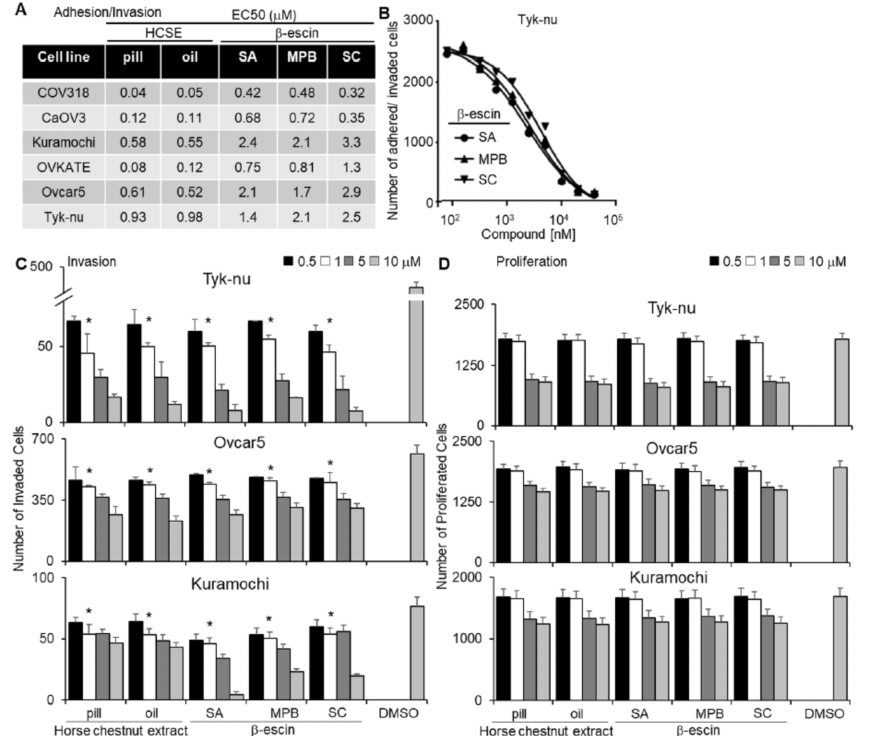
Figure 1. Testing different sources of β -escin in functional assays using a 3D organotypic model. Two horse chestnut extracts (HCSE) and three different sources of β -escin were tested at 12 doses in five high-grade serous ovarian cancer (OvCa) cell lines for their inhibitory effect on OvCa cell adhesion/invasion to the 3D organotypic model (16 h). ( A ) The half-maximal response values (EC 50 ) for each β -escin source in each cell line in the adhesion/invasion assays to the 3D organotypic model (16 h). ( B ) Representative dose − response curves of different β -escin sources for the Tyk-nu OvCa cell line in cell adhesion/invasion assays to the 3D organotypic model (16 h, mean ± standard deviation, n = 8). ( C , D ). Invasion and proliferation assays were performed. The effect of β -escin sources at four doses were tested in three OvCa cell lines. C . OvCa cell invasion (24–48 h) was tested using a 96-well Boyden chamber lined with collagen type I and the 3D organotypic culture. ( D ) The effect of β -escin on OvCa cell numbers after treatment (96 h) was tested in 384-well plates on the 3D organotypic culture. Mean ± standard deviation. *, p < 0.05, n = 5–8. DMSO—dimethyl sulfoxide; SA—Sigma Aldich; MPB—MP Biomedicals; SC—Santa